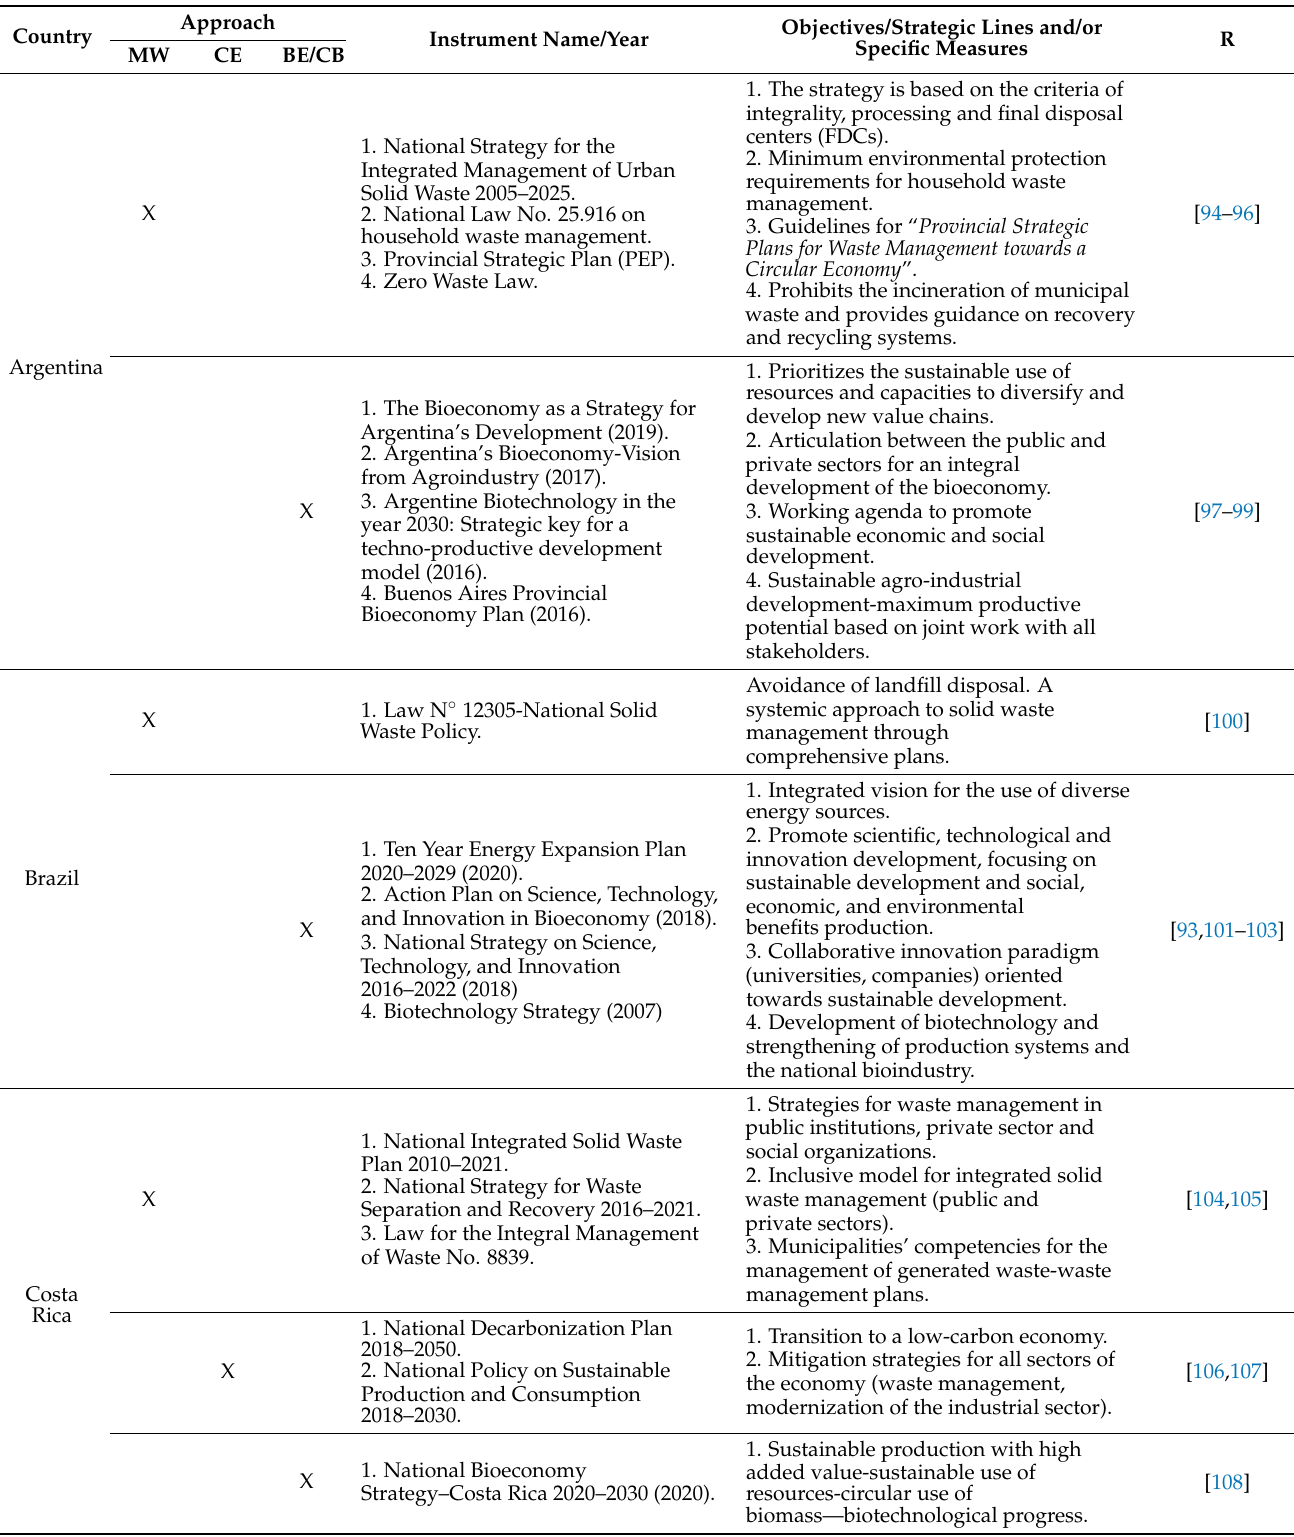
Table 5. Main management and regulatory instruments on waste and